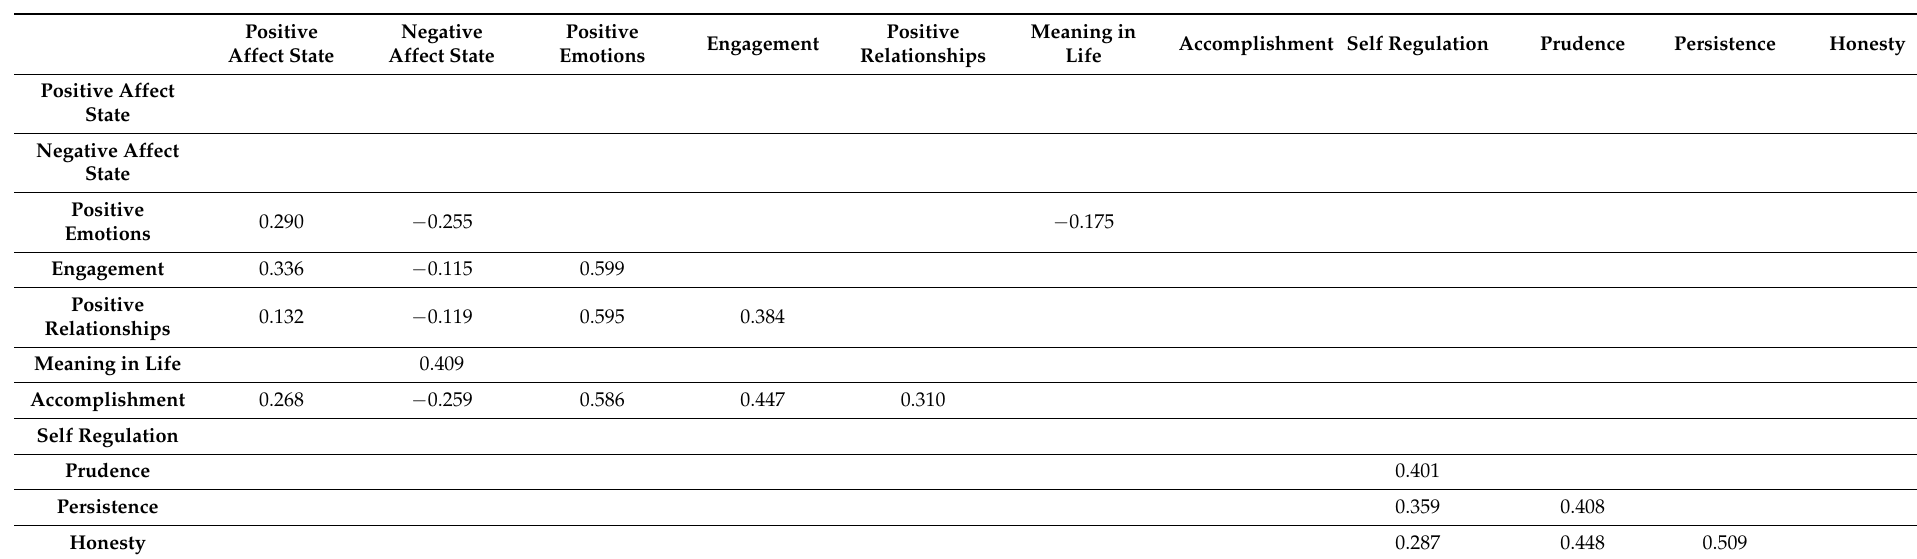
Table 4. Correlations between virtue of restraint dimensions and subjective wellbeing